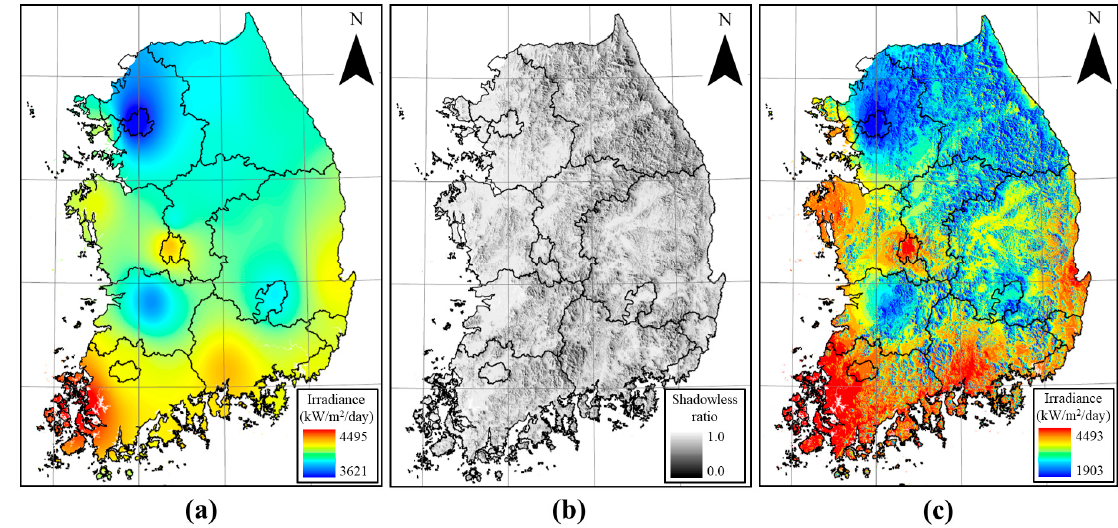
Figure 6. Irradiance prediction: ( a ) interpolated irradiance map; ( b ) shadowless ratio map; ( c ) irradiance map considering shadow by terrain.